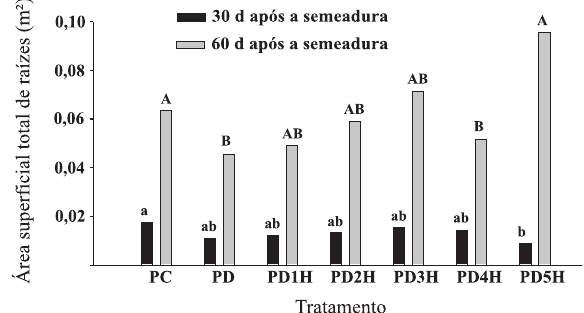
Figura 5. Área superficial total de raiz nos diferen- tes tratamentos, aos 30 e 60 d após a